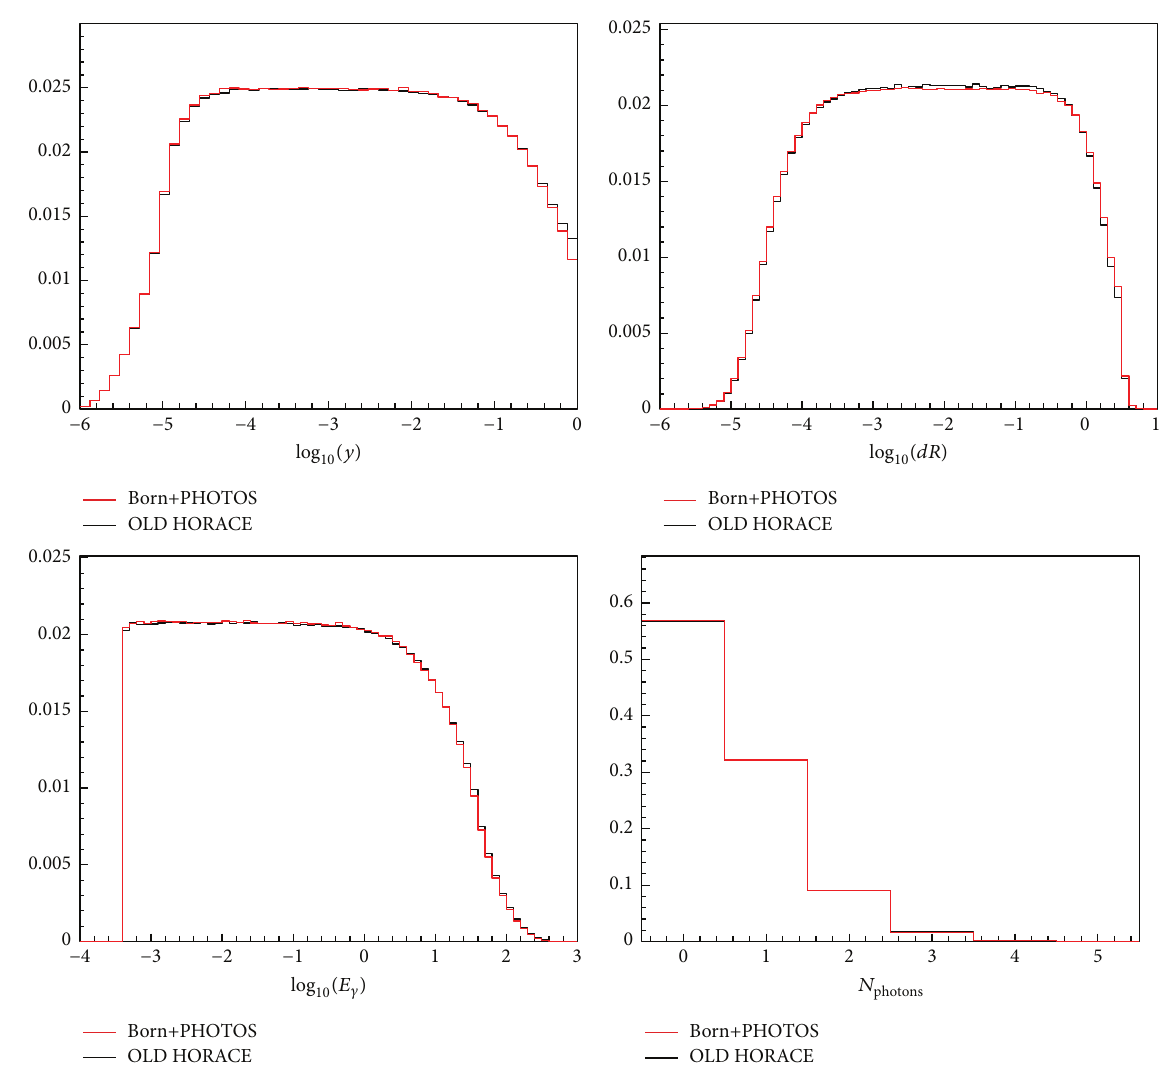
Figure 3: Clockwise from top-left: comparisons of the distributions of log 10 (𝑦 𝛾 ) , log 10 (Δ𝑅(𝑙𝛾)) , 𝑛 𝛾 , and log 10 (𝐸 𝛾 / GeV) for the 𝑊 + → 𝑒 + ] +𝑛𝛾 process between the “Born” mode of old horace interfaced with photos and old horace in the exponentiation mode. The Δ𝑅 is computed with respect to the